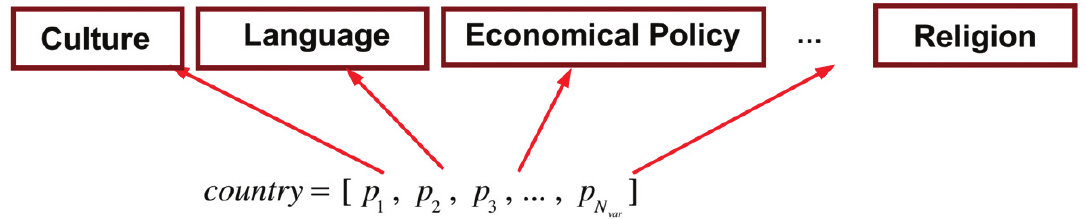
Figure 3. The candidate solutions of the problem, called country, consists of a combination of some socio-political characteristics such as culture, language and